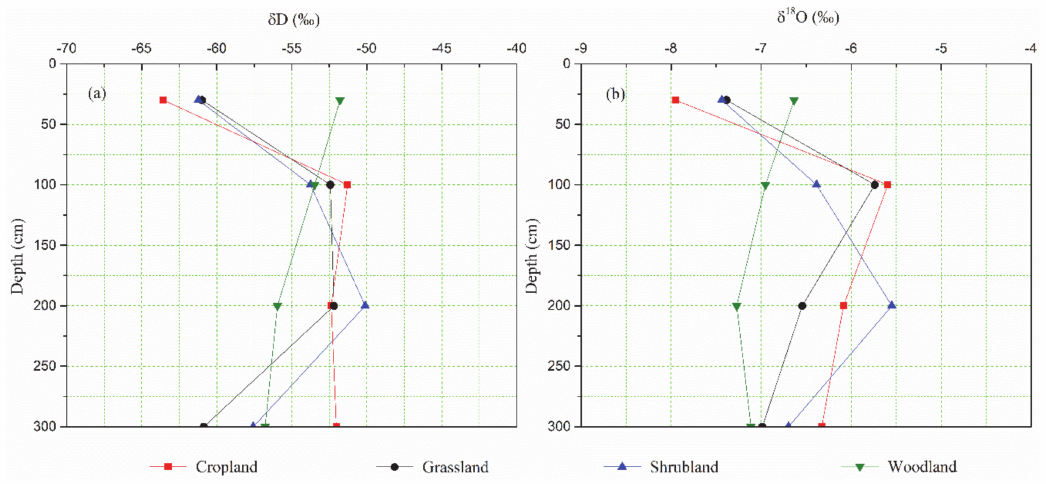
Figure 5. Profile distributions of δ D and δ 18 O in soil water under different land use types (( a ) δ D, ( b ) δ 18 O, measurements date: 17 June